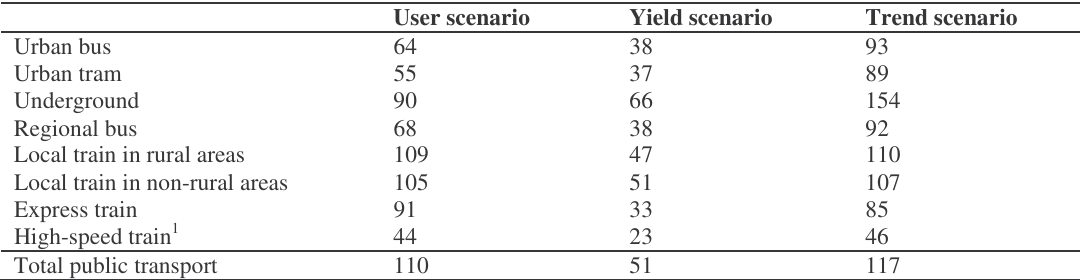
Table 9. Estimated demand for public transport (1998 = 100) User scenario Yield scenario Urban